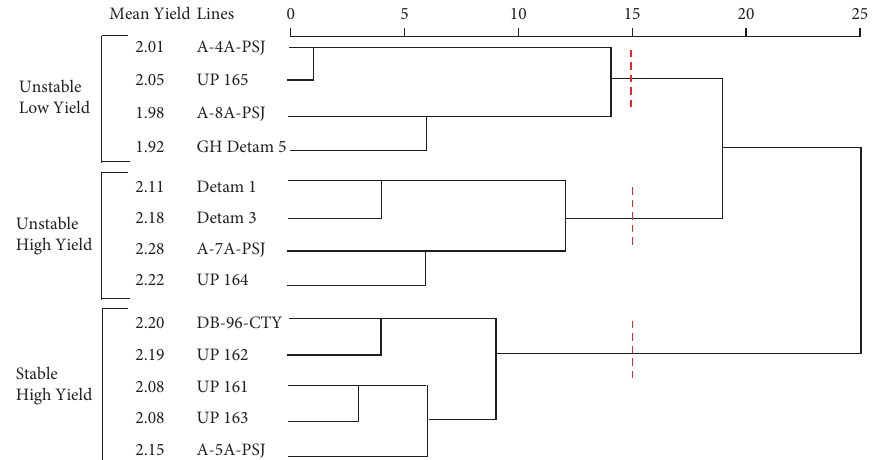
Figure 3: Clustering of soybean lines based on parametric and nonparametric measurements in